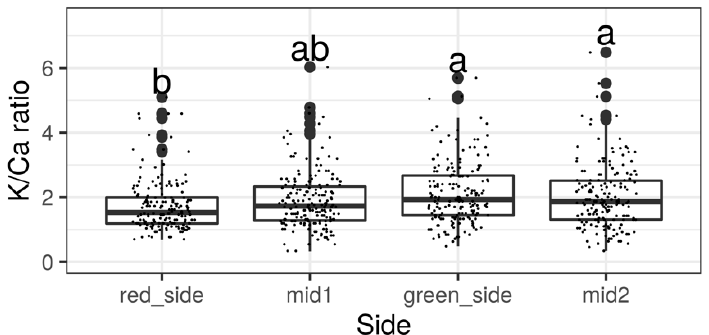
Figure 6. Spatial distribution of potassium and calcium ratios along the fruit equator. K / Ca ratio as measured on four sides per apple along the equator of the fruits using XRF for the trial 2018 to 2019. The red, sun-exposed side showed a significantly lower K / Ca ratio as compared with the green side facing the inside of the tree. The sections in between showed intermediate values. Significant di ff erences in the K / Ca ratios were caused by significant di ff erences in the calcium concentrations and constant levels of potassium levels, as already stated above with the di ff erent orchards. Letters denote significant di ff erences after the Kruskal–Wallis rank sum test and Dunn post-hoc